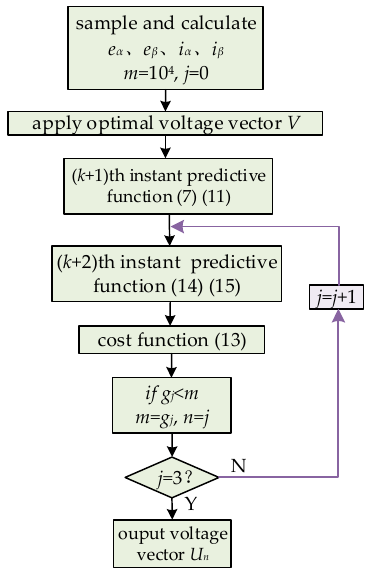
Figure 6. Flow diagram of MPDPC for fault-tolerant BVSC.